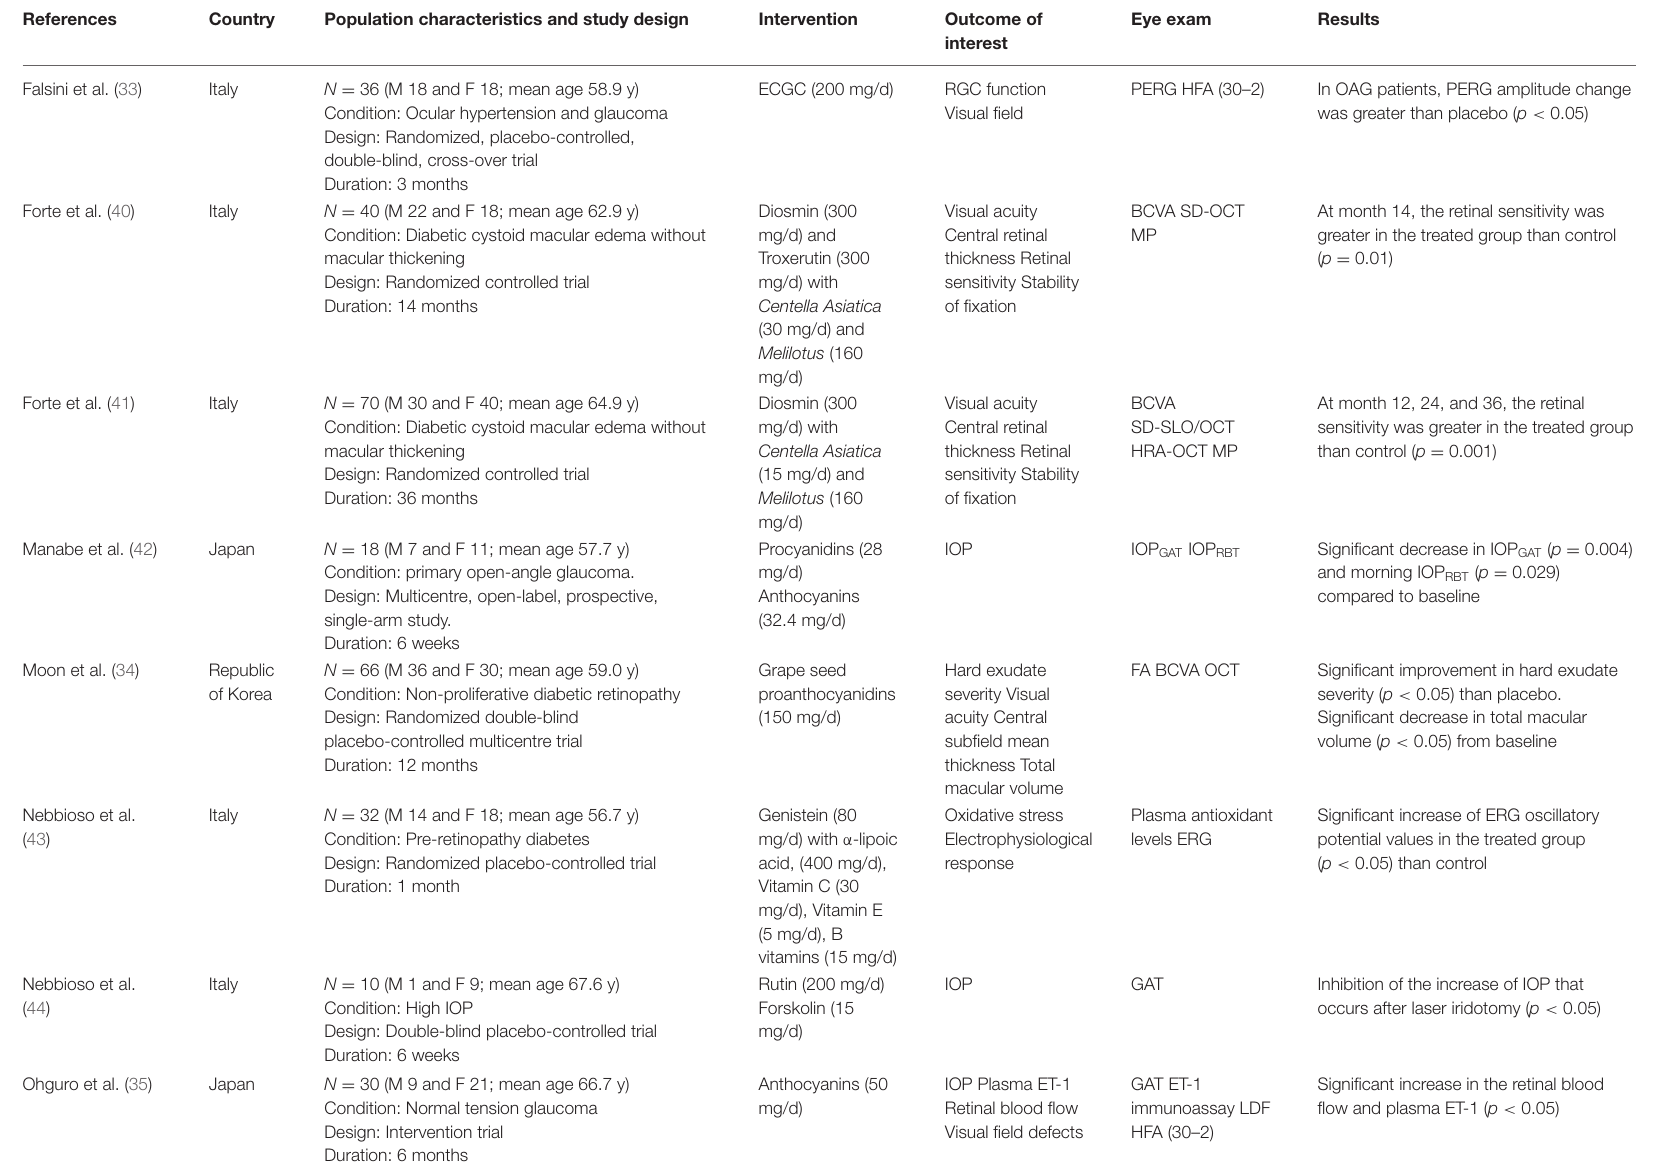
TABLE 1 | Characteristics of studies included in the systematic